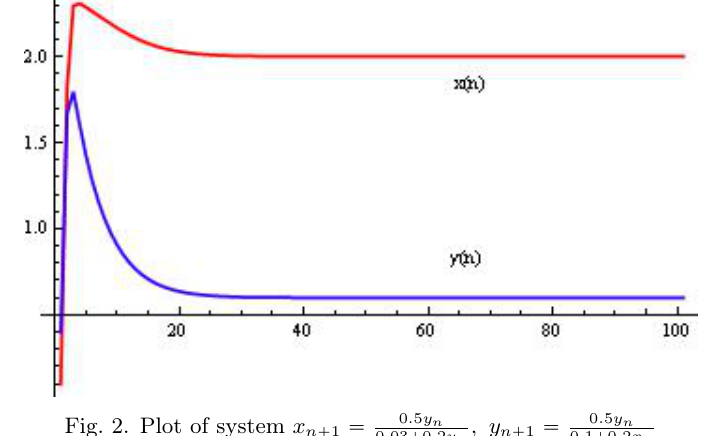
Fig. 2. Plot of system x n ` 1